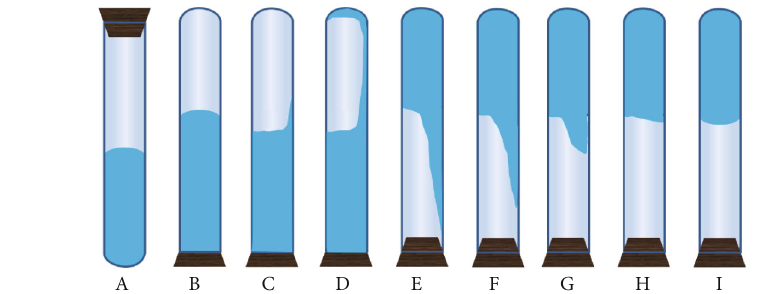
Figure 2: Schematic diagram of gel strength rating.